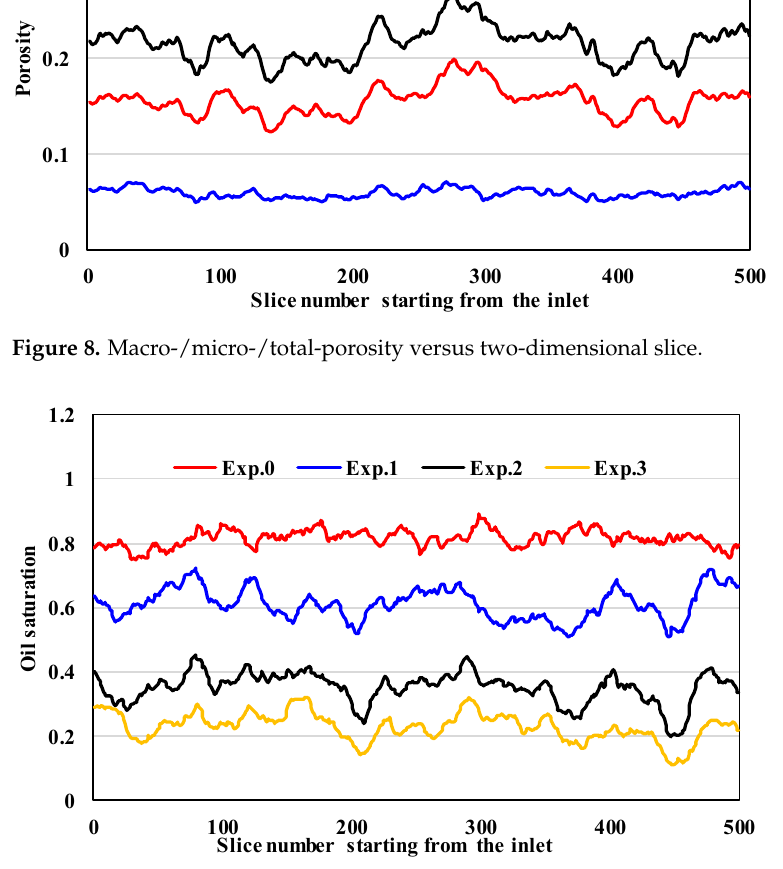
Figure 9. Oil saturation in different stages versus two-dimensional slice.